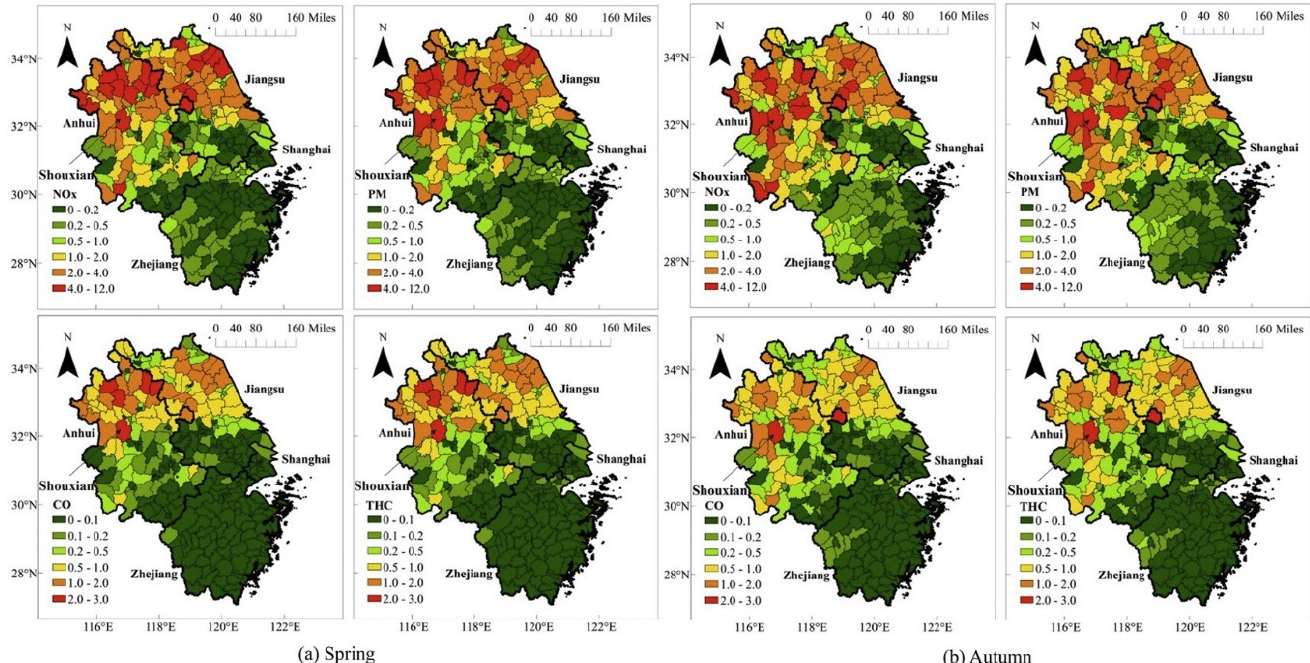
Figure 5. Ratio of emissions from agricultural machinery and road vehicles during busy season ( a ) Spring and ( b ) Autumn in the Yangtze River Delta of China [45].